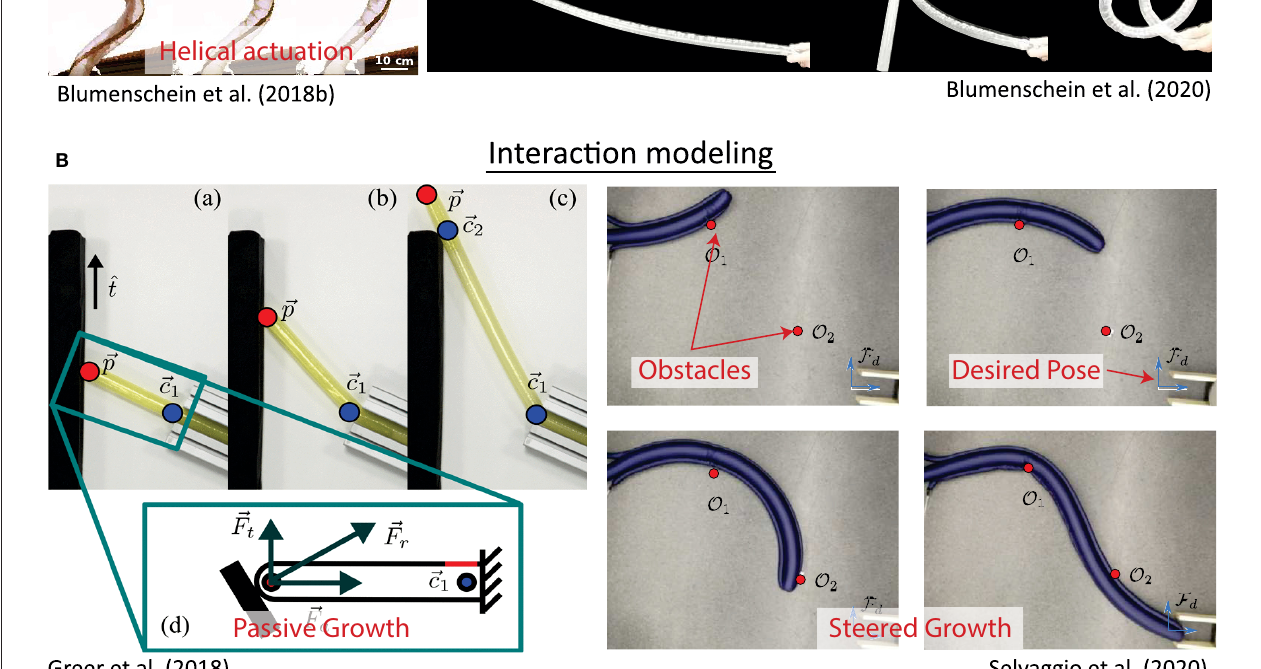
Frontiers in Robotics and AI |